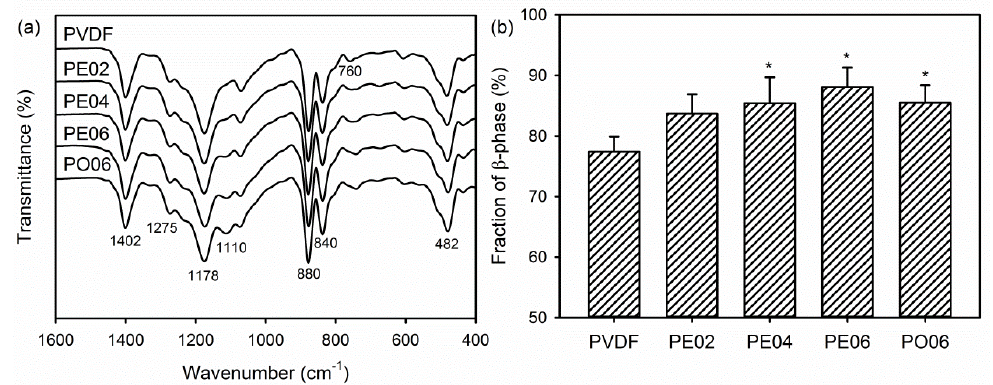
Figure 3. ( a ) FTIR spectra of the PVDF composite nanofibers and ( b ) changes in β-phase content in the nanofibers calculated from the FTIR spectra ( n = 5). Significant difference from the pure PVDF nanofiber was denoted as p * ˂